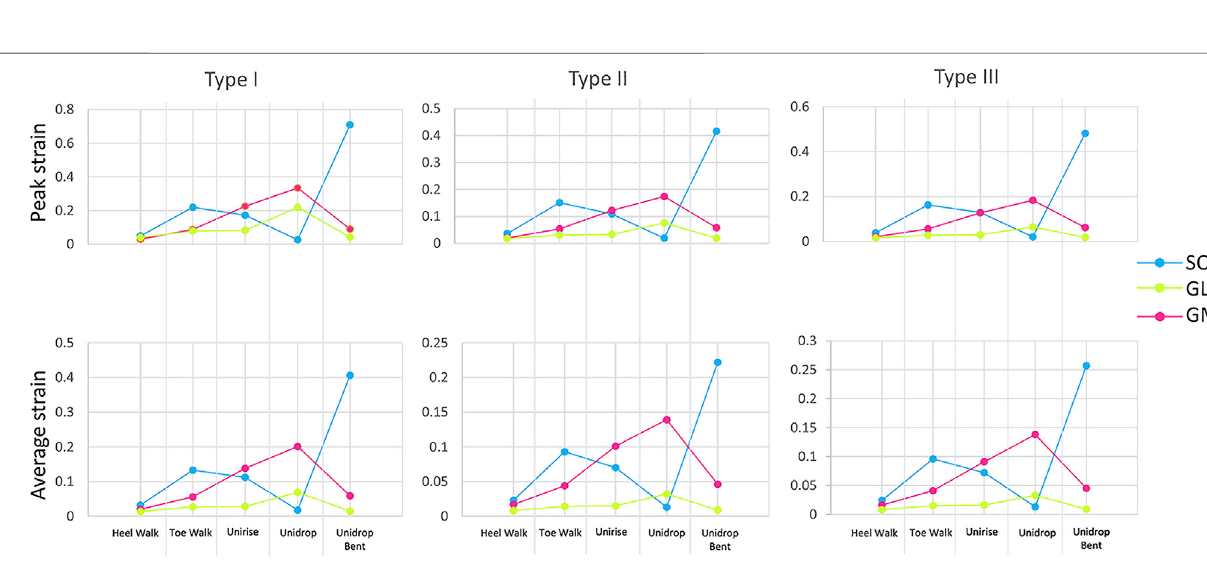
Frontiers in Bioengineering and Biotechnology |